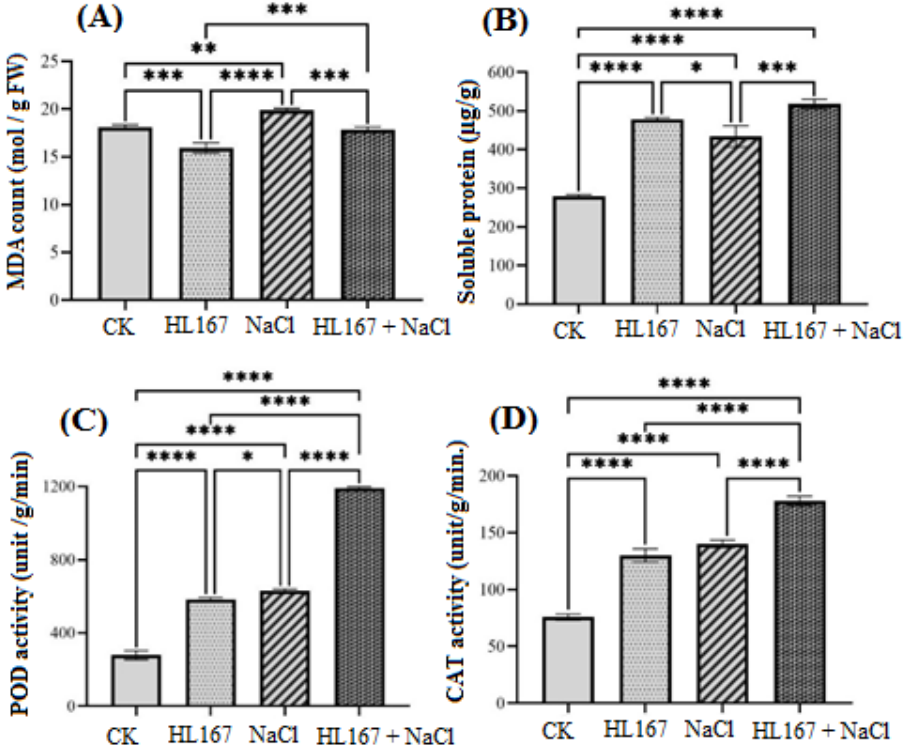
Figure 9. Effect of salt stress and T. longibrachiatum HL167 treatments on cowpea. ( A ) MDA (malondialdehyde), ( B ) soluble protein, ( C ) POD (peroxidase) activity, and ( D ) CAT (catalase) activity. CK represents cowpea seedlings grown under normal condition; HL167 represents cowpea seeds pretreated with T. longibrachiatum HL167 without salt treatment; NaCl represents cowpea seedlings stressed under 200 mM NaCl; HL167 + NaCl represents cowpea seeds pretreated with T. longibrachiatum HL167 then treated with 200 mM NaCl saline. Small bars represent the standard errors. The asterisk (*) indicates p < 0.05, (**) indicates p =0.001, (***) indicates p < 0.0007, (****) indicates p < 0.0001.